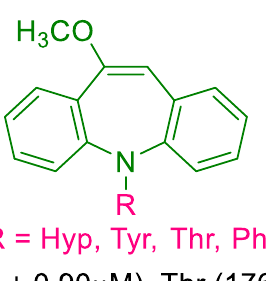
Figure 23. Amino acids-diphenylmethylpiperazine hybrid molecules. Kumar H et al. have developed conjugates of L -amino acids (Thr, hydroxypro- line (Hyp), Phe and Tyr) attached to 10-methoxy-dibenz[ b , f ]azepine ( 16 ) via 3-chloro- 1-(10-methoxy-5H-dibenz[ b , f ]azepine-5-yl)propan-1-one intermediate, which were synthe- sised by N-cyclisation of 10-methoxy-dibenz[ b , f ]azepine with 3-chloro-propionylchloride (Figure 24). The synthesised analogues were screened for DPPH radical scavenging assay from which it was observed that the free amino acids showed the least rate of activity than the standards (BHA and ascorbic acid). On the other hand, the coupling of interme- diates to amino acids led to an enhanced activity which may be due to the presence of a methoxy group in the heterocyclic system. The key intermediate did not retain radical scavenging property, but when conjugated with amino acids, enhanced activity was ob- served. The conjugates of Thr, Hyp and Tyr exhibited enhanced activity. The enhanced activity of Tyr conjugate was due to the presence of phenolic moiety, whereas decreased activity was observed for Phe conjugate. This may be due to the absence of a hydroxyl group. Among the synthesised conjugates, 1-(3-(5H-dibenz[ b , f ]azepine-5-yl)-3-oxopropyl)- 3hydroxypyrolidine-2-carboxylic acid showed the highest activity with an IC 50 value of 4.1 ± 0.87 µ M/mL, which might be due to the presence of a hydroxyl group of Hyp [111].